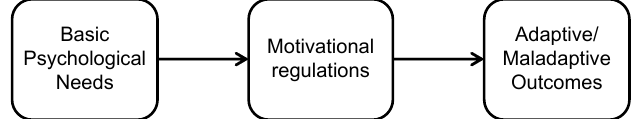
Figure 1. Main tenets of self-determination theory (Deci & Ryan, 1985,